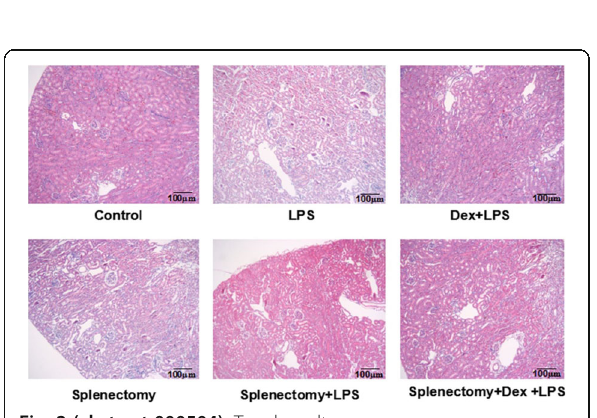
Fig. 2 (abstract 000504). Tunel results